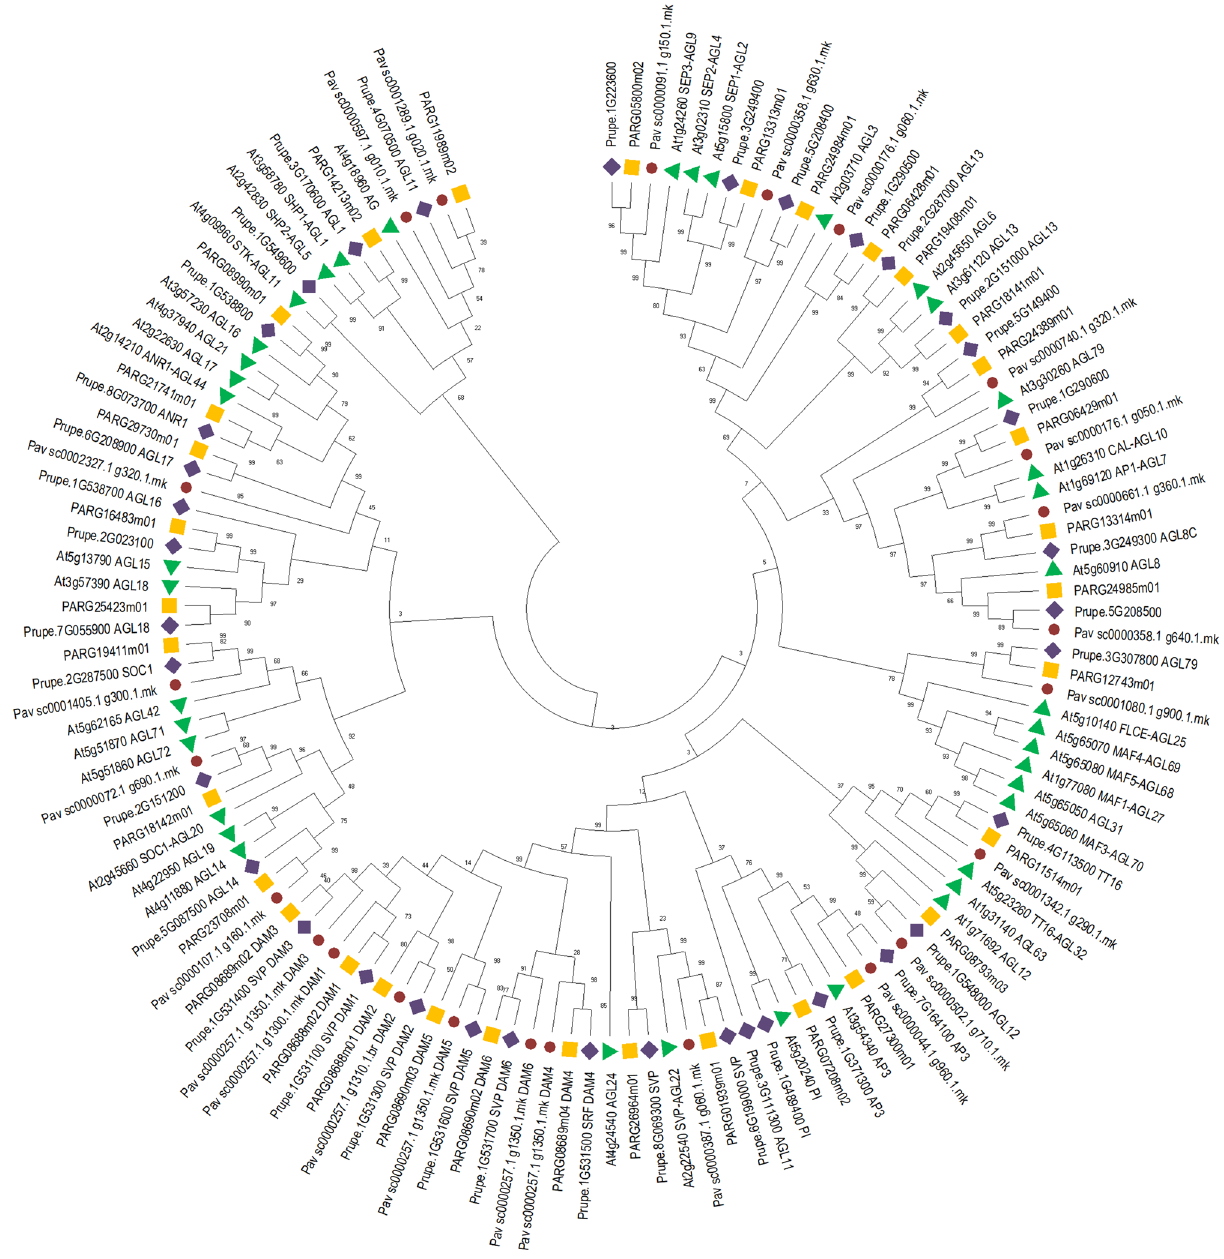
Figure 1. Neighbor-Joining consensus tree of MYKC MADS-box proteins from peach, apricot, cherry and Arabidopsis. The tree is based on a ClustalX alignment and was inferred in MEGAX 58 with 1000 bootstraps using the Neighbor-Joining method 59 . The evolutionary distances were computed using the JTT matrix-based method 60 and are in the units of the number of amino acid substitutions per site. The analysis involved 133 amino acid sequences. Green triangles, lilac diamonds, brown circles and yellow squares colors represent Arabidopsis, peach, sweet cherry and apricot proteins